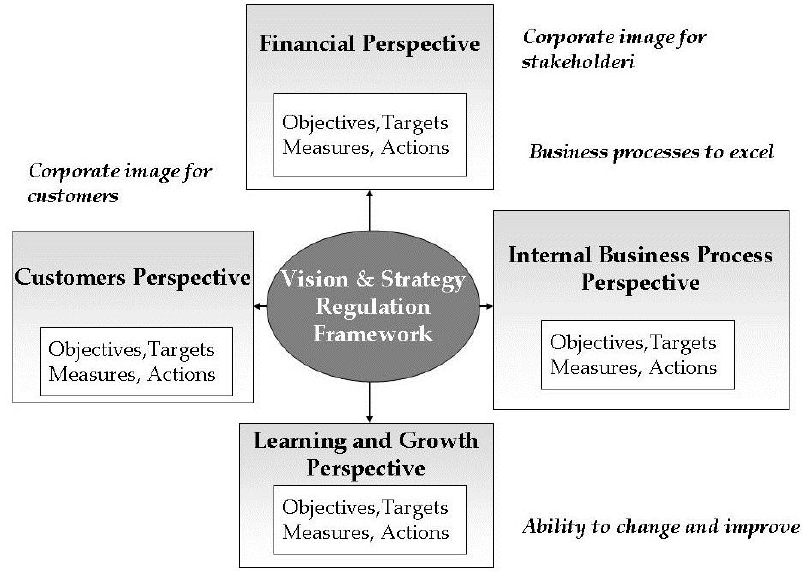
Figure 2. Balanced Scorecard of Transelectrica [60].